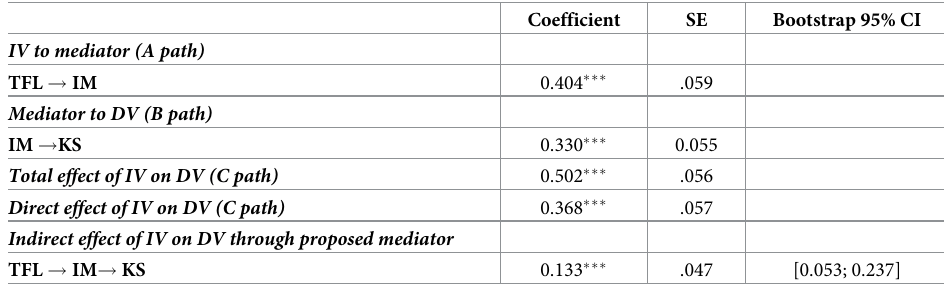
Table 6. Results of the mediation analyses of PAL, IM, and KS (without covariates).